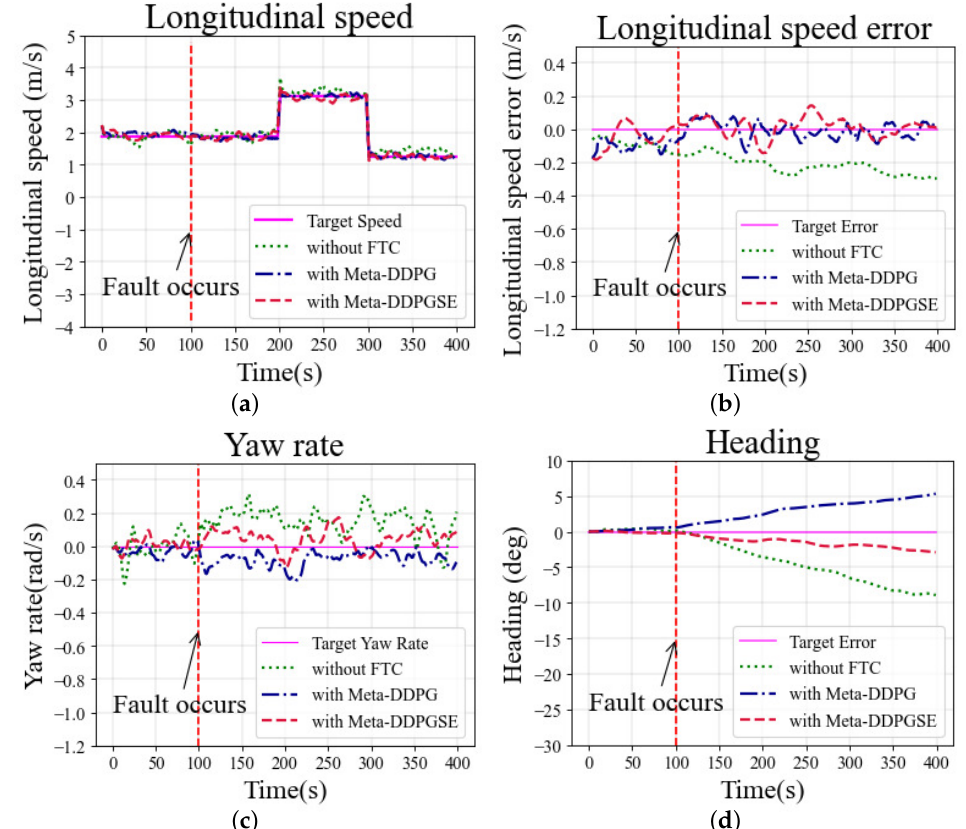
Figure 7. Simulation results in the straight scenario with fault F ∗ tudinal speed error; ( c ) Yaw rate; ( d )